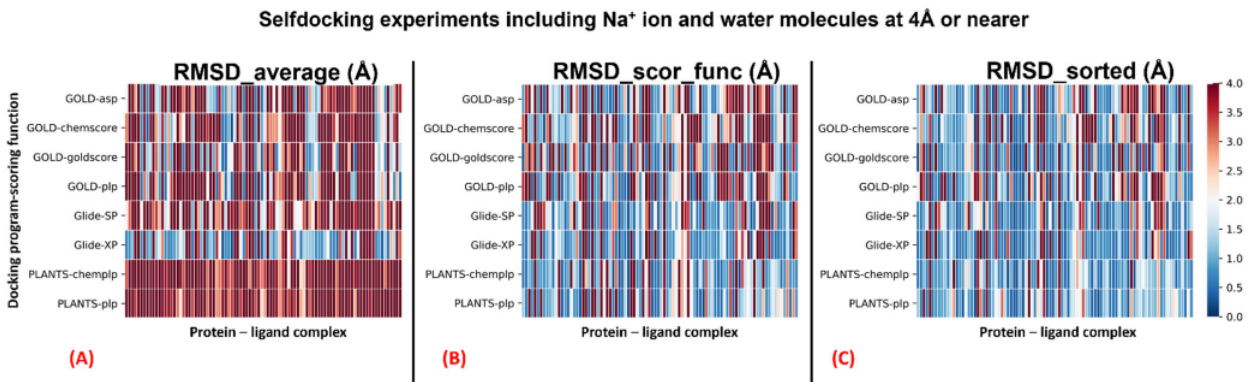
Figure 2. Colormaps show the results of the self-docking calculations executed considering the sodium ion and the water molecules at 4 Å or nearer to it within the GPCR receptor 7TM region of the 118 complexes examined in this study. The three plots depict respectively: ( A ) the outcomes derived from the average of the RMSDs of all the poses for each docking run (“RMSD_average”); ( B ) the results obtained just from the RMSD between the crystallographic ligand coordinates and the best-ranked pose from the scoring function (“RMSD_scor_func”); ( C ) the results of the self- docking experiments if just the pose showing the best RMSD value between its coordinates and the crystallographic ones are considered (“RMSD_sorted”). The x-axis enumerates all the different GPCR– antagonist complexes, which are plotted against the different docking program–scoring function pairs used for our study, reported on the